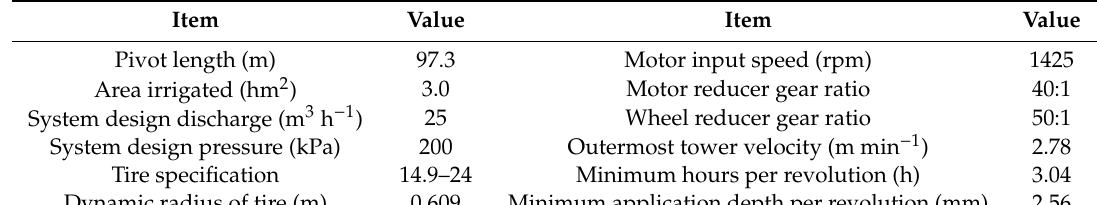
Figure 1. Structural components of the investigated center pivot irrigation system. Table 1. Technical parameters of the center pivot irrigation system.